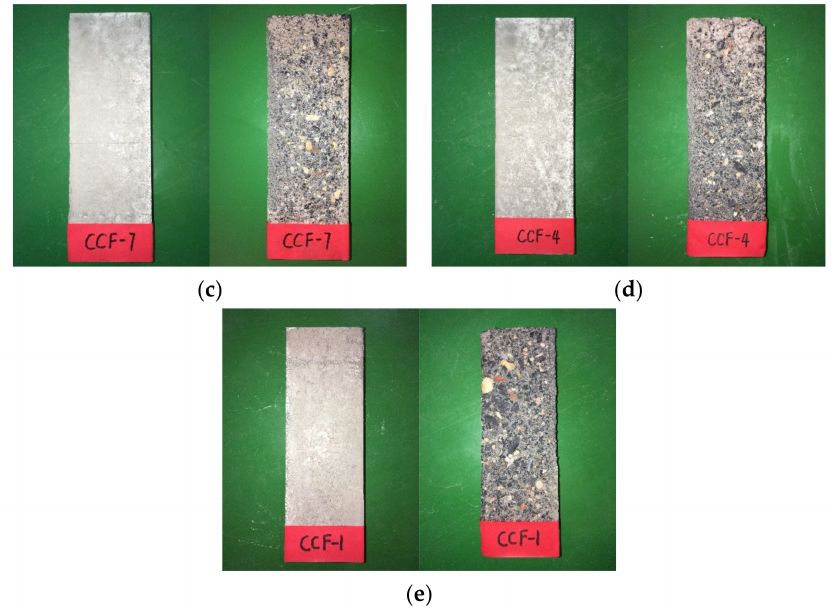
Figure 4. The phenomenon of seawater freeze–thaw cycle test. ( a ) Comparison before and after 25 freeze–thaw cycles. ( b ) Comparison before and after 50 freeze–thaw cycles. ( c ) Comparison before and after 75 freeze–thaw cycles. ( d ) Comparison before and after 100 freeze–thaw cycles. ( e ) Comparison before and after 125 freeze–thaw cycles.